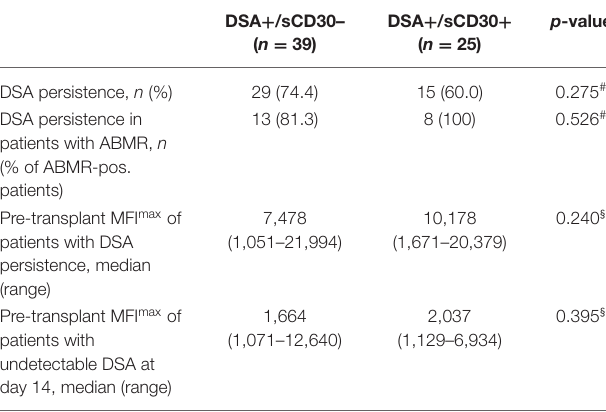
TABLE 3 | DSA-status 14 days post-transplantation.